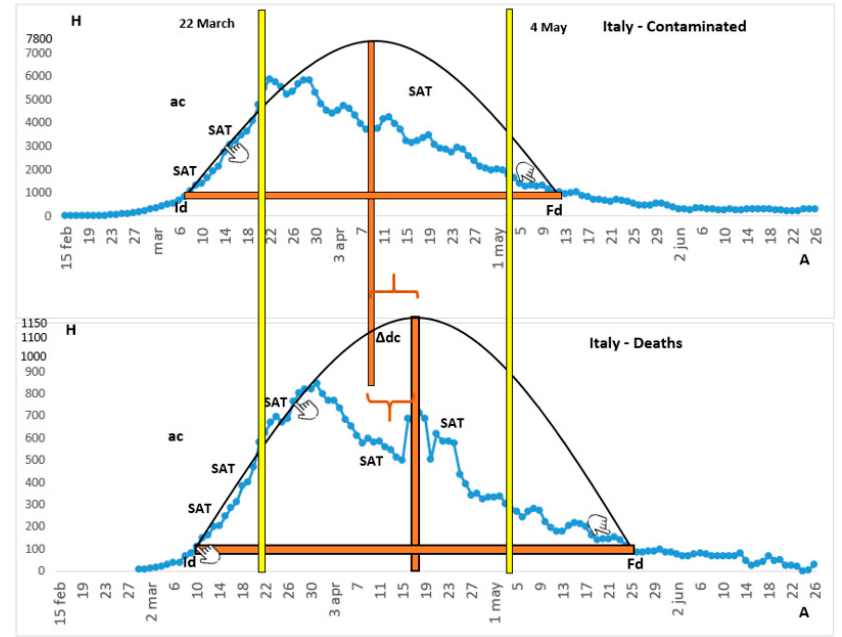
Figure 2. The contaminated people and deaths due to COVID-19 in Italy. Note. Id, initial date; Fd, final date; SAT, saturation point; ac, acceleration; -ac, deceleration; H, height; A, amplitude: ∆ dc, period between the deaths and contaminated peaks of the ideal curve.